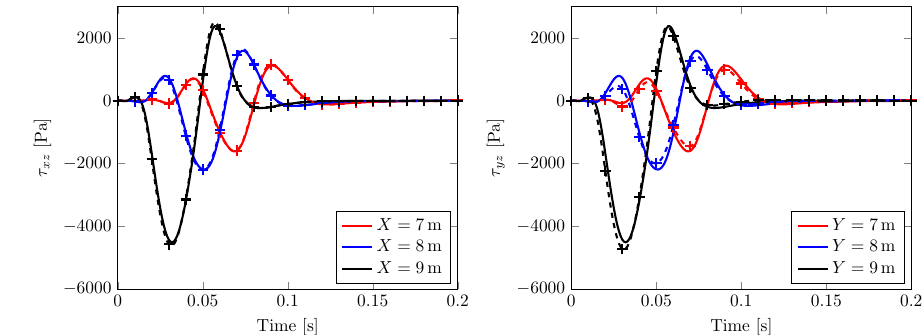
Figure 18. Transversely isotropic soil model with constitutive model of solid phase rotated by α = 90 ◦ : deformed meshes (amplified by scale factor 500) and contours of norm of soil displacements vector = u S (cid:107) (cid:107) (cid:113)